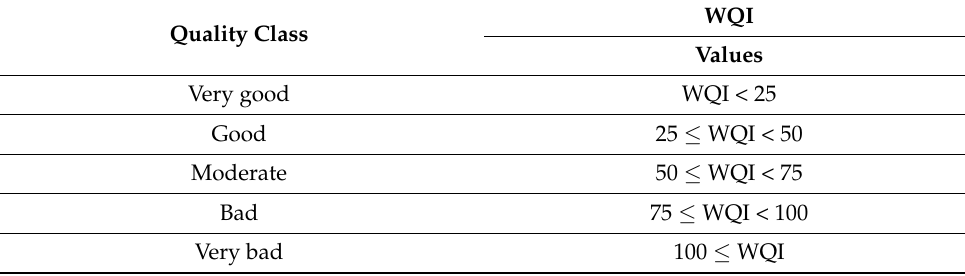
Table 8. Comparison of Danube River Chilia branch water quality classification * according to CCME WQI and